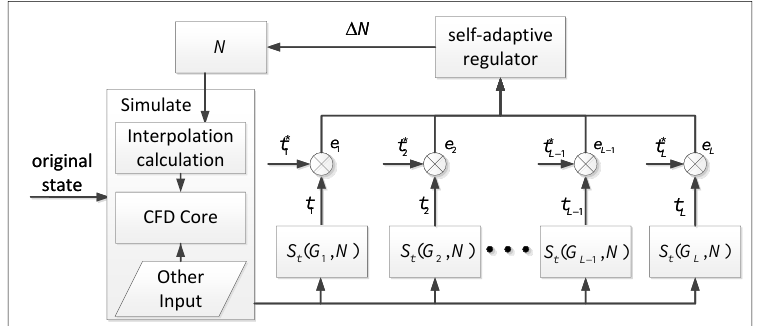
Figure 5. Adaptive control